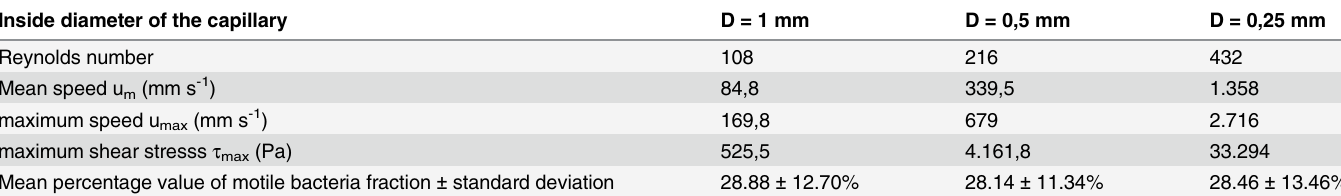
Table 4. Flow conditions in the capillary of shear stress evaluations.